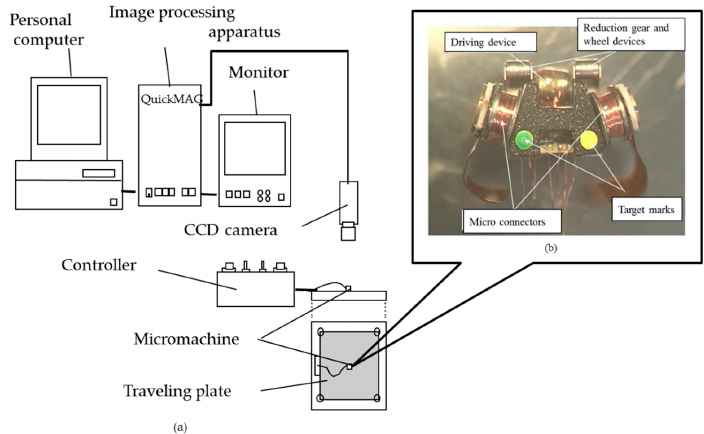
Figure 16. ( a ) Configuration of turning characteristics evaluation system. The system consisted of a traveling plate, a controller, a CCD camera, an image-processing apparatus, a monitor, and a personal computer. ( b ) Top view of microrobot. The green and yellow marks were target marks for position detection. The marks were 1 mm in diameter, 3.66 mm apart and were located 1.55 mm behind the microrobot center.